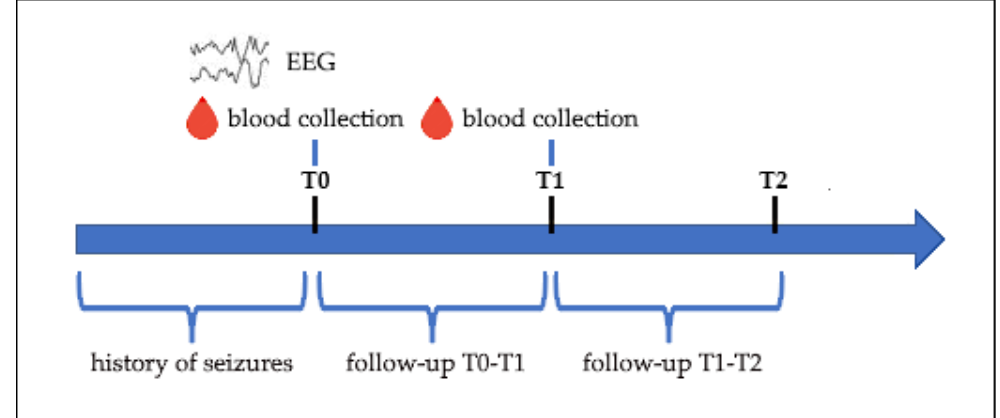
Figure 2. The timeline of the